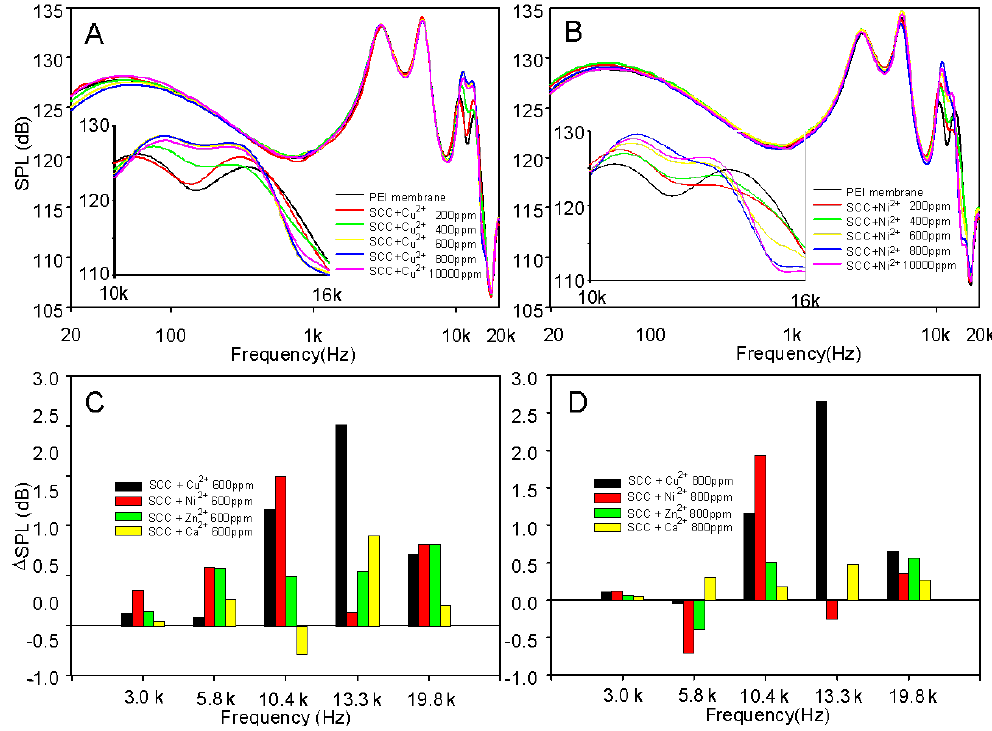
Figure 2. Frequency response curves of PEI-earphone diaphragms made of SCC/Cu 2+ ( A ) and SCC/Ni 2+ ( B ) composites. Differences of sound pressure level , including SCC/Cu 2+ , SCC/Ni 2+ , SCC/Zn 2+ , and SCC/Ca 2+ composites on PEI diaphragms at 600 ( C ) and 800 ( D ) ppm. ΔSPL = [SPL] composites − [SPL] blank .